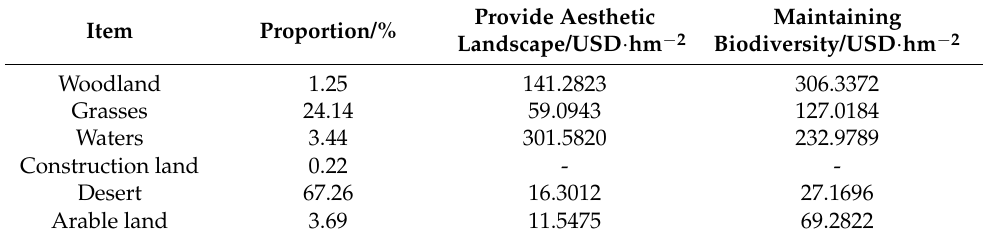
Table 4. Land use type area and ecological service value of the Tarim River Basin. Provide Item Proportion/%